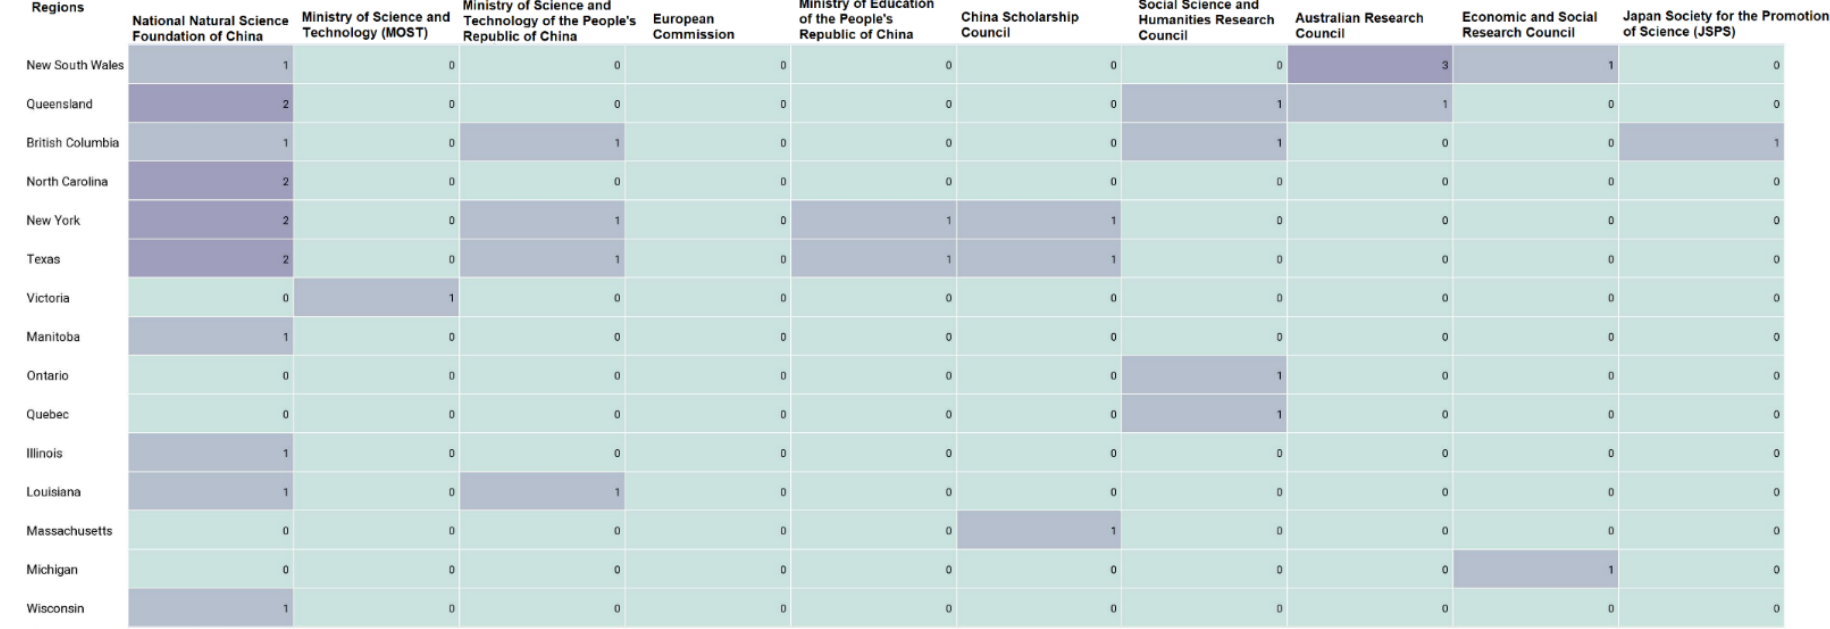
Figure 10. Peering Funders Ministry and Regions in Figure 10 . Peering Funders Ministry and Regions in Aerotropolis .